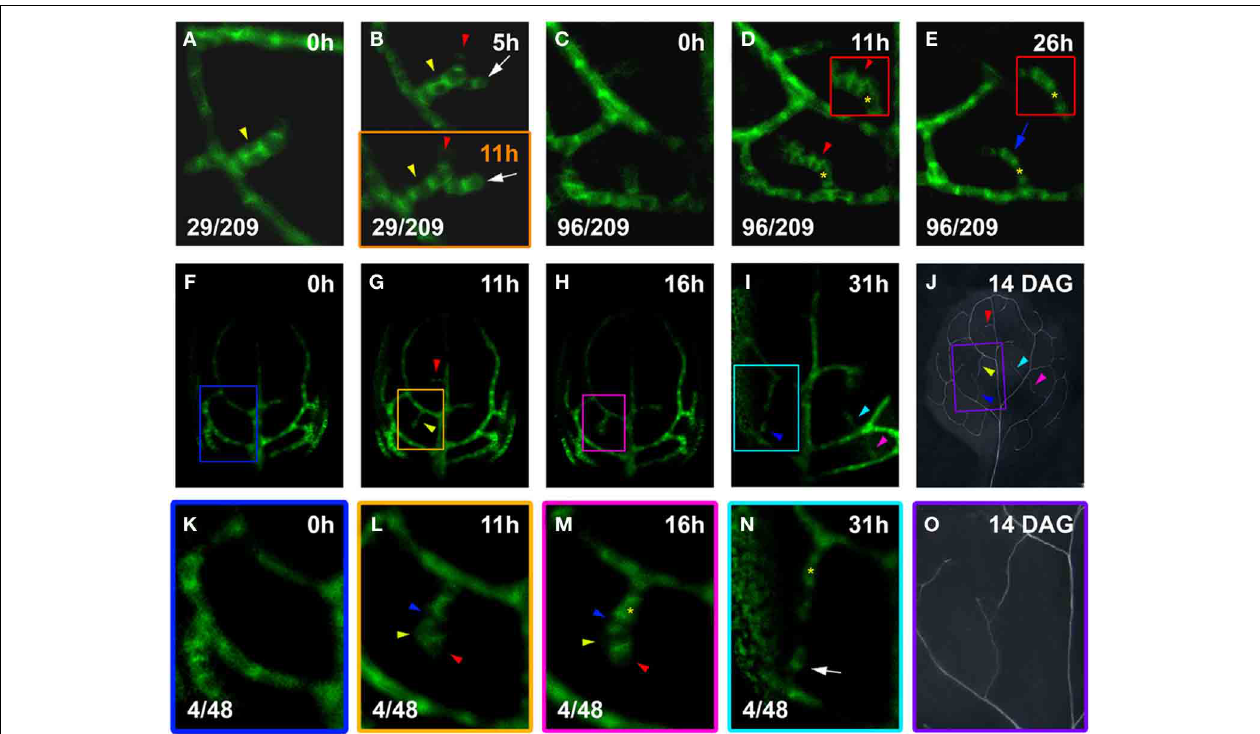
FIGURE 4 | hPED branching and narrowing. Top left, time after first imaging ( t = 0; A–I , K–N ) or at DAG (J,O) . Bottom left, reproducibility quotient ( Table 2 ). Scale bars: ( A–E , K–N ) 10 µ m; (F–I) 20 µ m; ( J,O) 1mm. (A,B) Freely-ending four-cell hPED (A) , by 5h extended by one cell (red arrowhead, B ) and associated with side branch (white arrow). By 11h ( B , lower panel), cells of the new side branch (white arrow) elongated with increased PIN1 expression. Yellow arrowheads in (A,B) indicate where hPED is originally two cells wide ( A,B upper panel). By 11h ( B , lower panel), PIN1 expression has been lost by the upper cell (yellow arrowhead), resulting in a hPED that is uniformly 1-cell wide. (C–E) At 0h (C) , a freely-ending hPED extends from the third loop PED. By 11h, PIN1 upregulated in a group of cells (red arrowhead). Upper cells of this new domain (see red-boxed inset in D ), display PIN1 polarity toward hPED center (red arrowhead). Lost PIN1 expression in these same cells (blue arrow, E ), while cells beneath maintained expression and elongated (red-boxed inset in E ). Same-cell mark (yellow asterisk, D,E ), as a positional reference. (F–J) PIN1:GFP expression and final vein pattern (J) ,